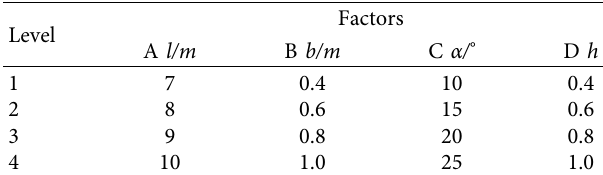
Figure 2: Schematic of the geometric parameters of the diversion pier: (a) relative height of diversion pier; (b) diversion pier length, width, and radian. Table 1: Orthogonal table of the forebay of the pumping station with a 45 ° lateral